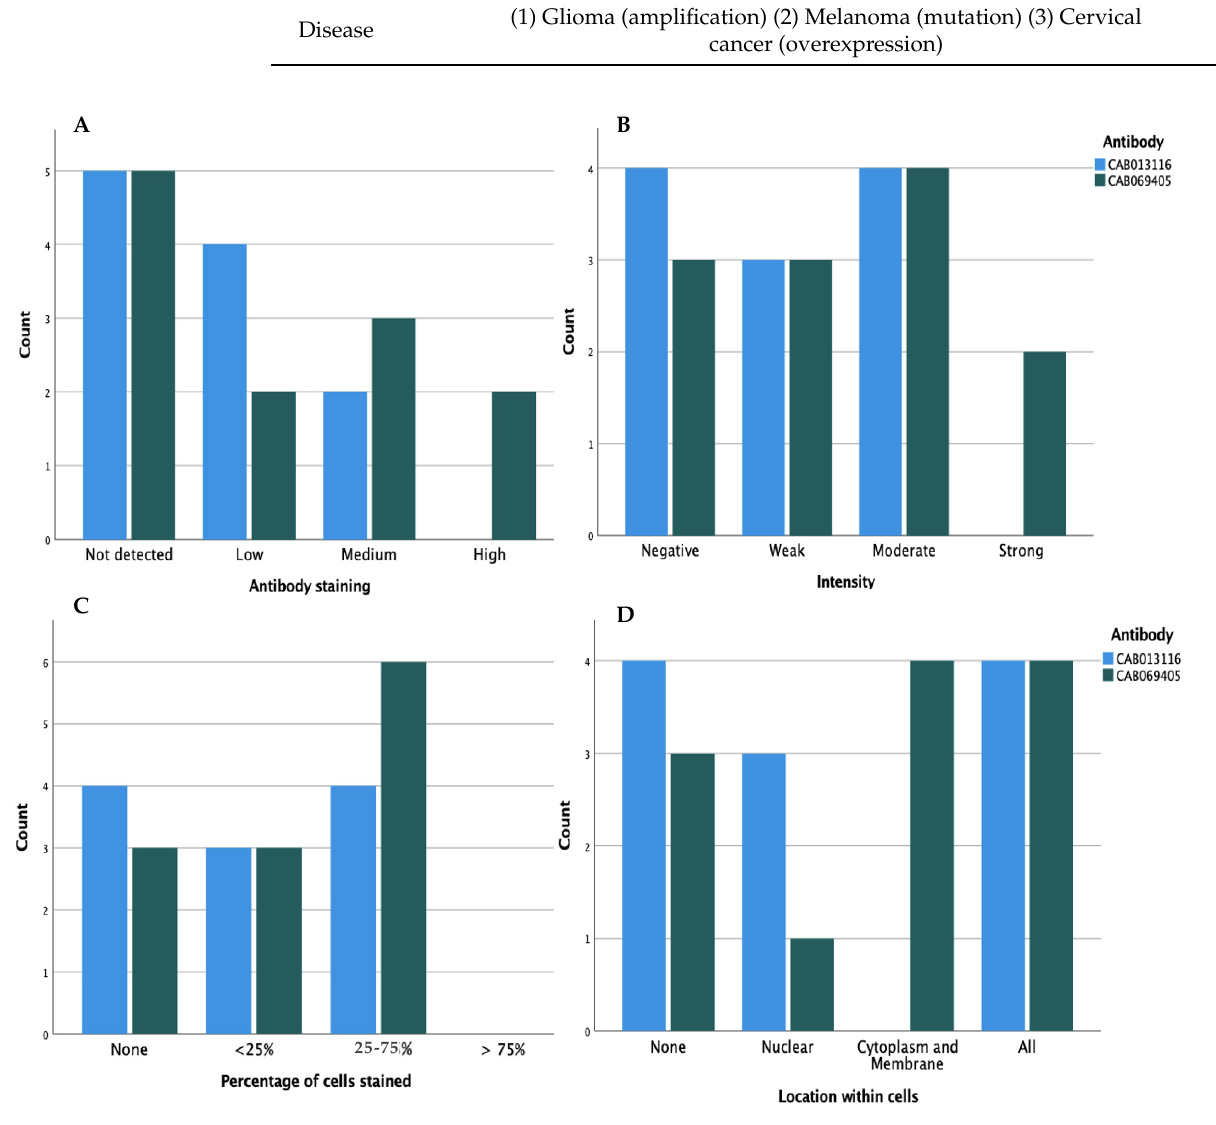
Figure 6. Clustered bar charts showing characteristics of two different CDK4 monoclonal antibodies (1—CAB013116 (ThermoFisher Scientific) and 2—CAB069405 (AbFrontier)) on tissue sections from pancreatic ductal adenocarcinoma patients. ( A ) The antibody staining levels, ( B ) The level of intensity, ( C ) The percentage of cells stained, ( D ) The location within cells.